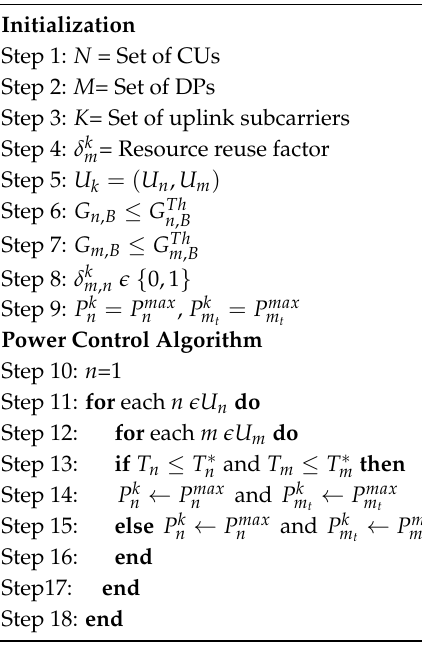
Algorithm 2: Binary Power Control